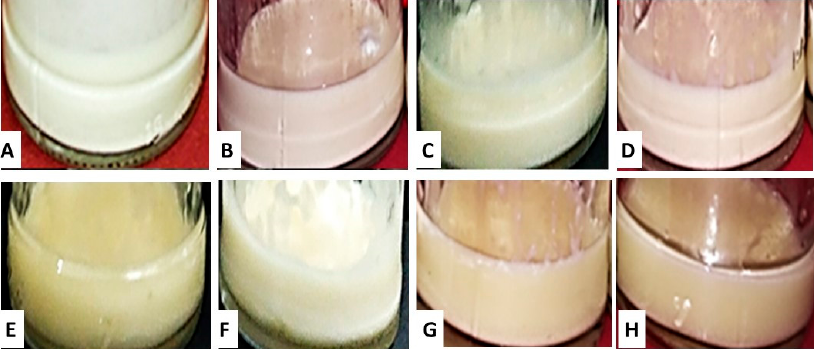
Figure 2. Texture of the Cedrela odorata essential oil (10%) and water (75%) mixture after their emulsification with different mixtures (15%) of the surfactants Tween 80 and Span 20. Hydrophilic–Lipophilic Balance (HLB) value of the surfactant mixtures: ( A ) 8.98; ( B ) 10.01; ( C ) 10.46; ( D ) 10.78; ( E ) 11.03; ( F ) 11.48; ( G ) 12.06; and ( H ) 12.89. Table 3. Creaming index of the Cedrela odorata essential oil emulsion from the effect of the Hydrophilic–Lipophilic Balance HLB of the Tween 80–Span 20 surfactant mixture. Essential oil/surfactant mixture/water = 10:15:75. Tween 80 Span